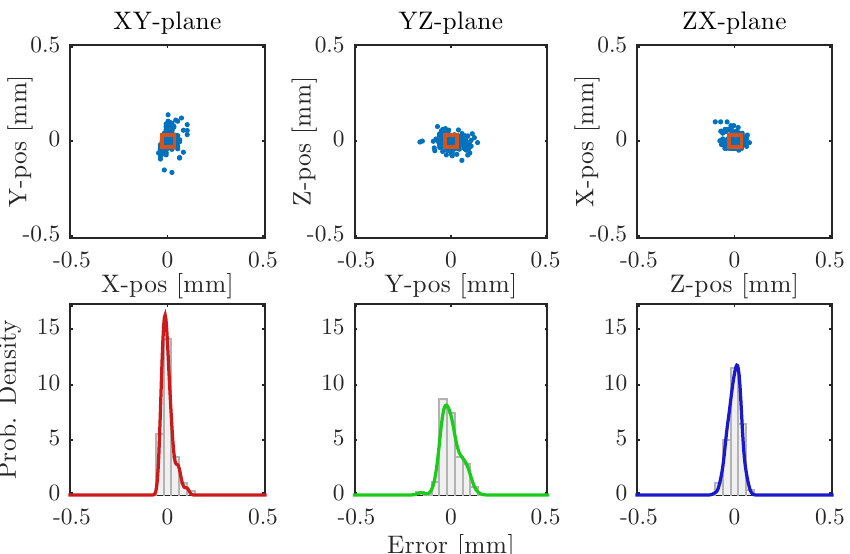
Figure 8. Planar position point-clouds ( top ) and deviation distribution ( bottom ) for 200 measurements of the pole-shoe TCP using a touch probe (Sensor A).